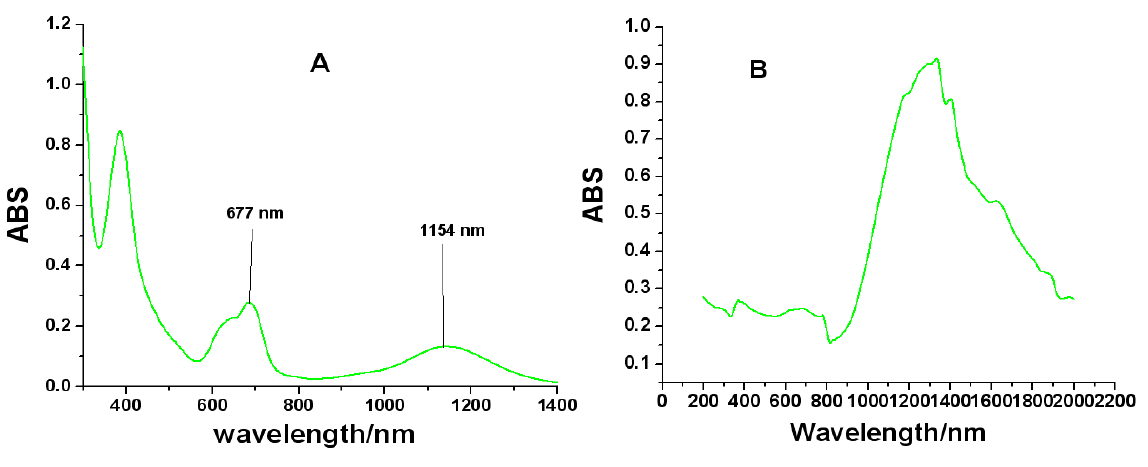
Figure 3. ( A ) UV-Vis/NIR spectrum of 1a in CHCl state UV-Vis/NIR Spectrum of 1a .